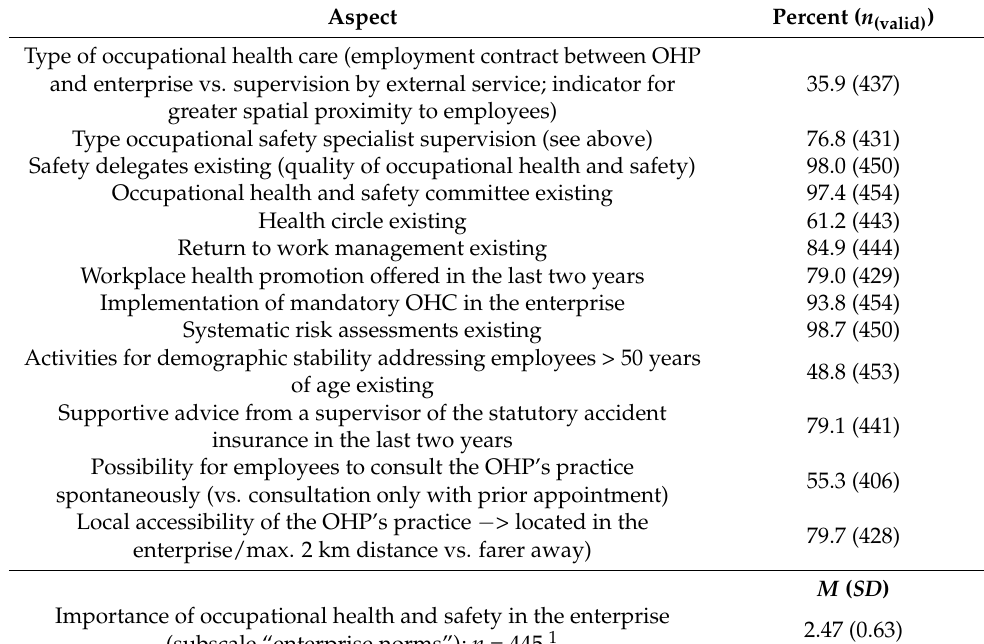
Table 2. Frame conditions of occupational health and safety in the described